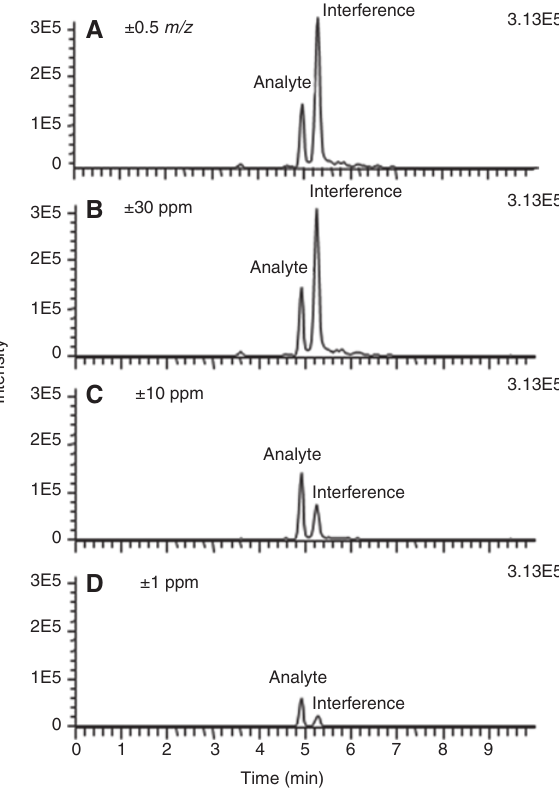
Figure 5 Effect of EIC window on assay selectivity and sensitiv- ity. (A) EIC window, ± 0.5 m/z ; (B) EIC window, ± 30 ppm; (C) EIC window, ± 10 ppm; (D) EIC window, ± 1 ppm (reproduced from Ruan et al. 2011, with